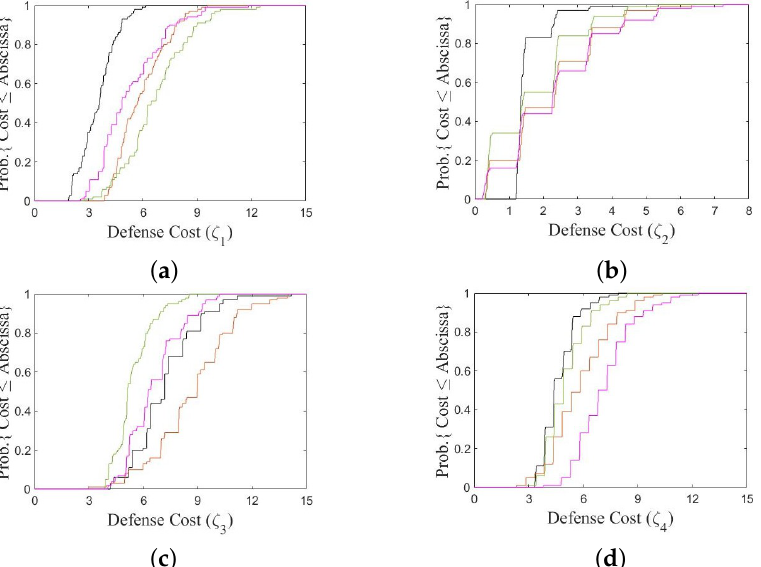
Figure 4. CDF of defense cost function against slant formation, ( a ) ζ 1 ; ( b ) ζ 2 ; ( c ) ζ 3 ; ( d ) ζ 4 , with four PSO